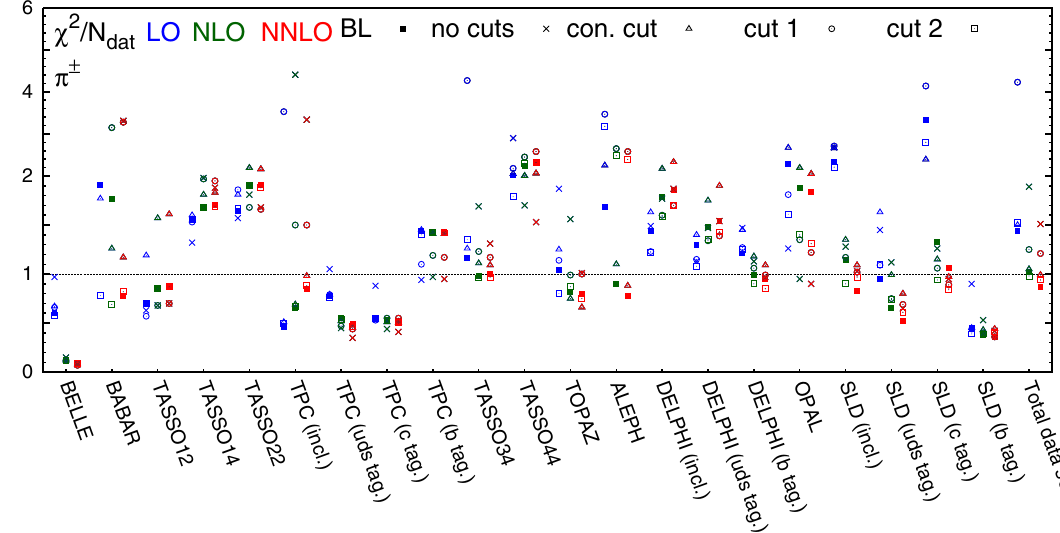
Fig. 14 The values of χ 2 / N dat for each fit to π ± data with the choices of small- z kinematic cuts summarised in Table 4, at LO, NLO, and NNLO